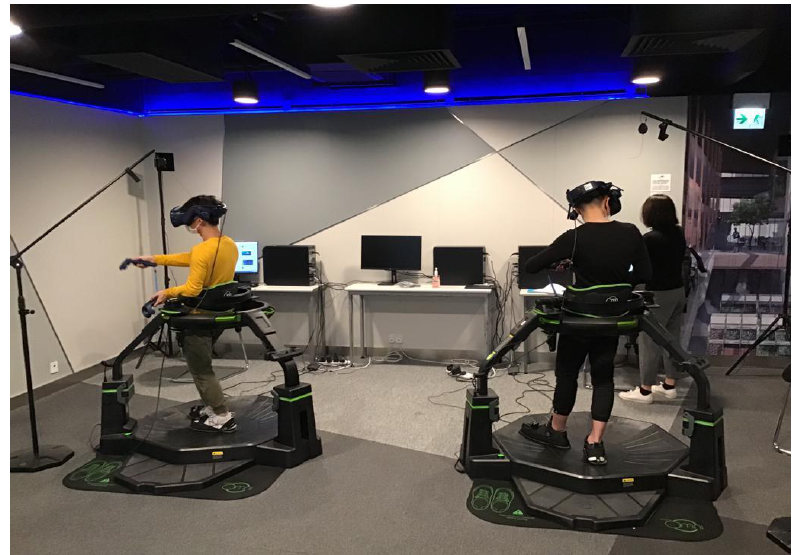
Figure 6. A pair of participants testing the system on MUVR treadmills. Table 1. Mean scores and results of the t